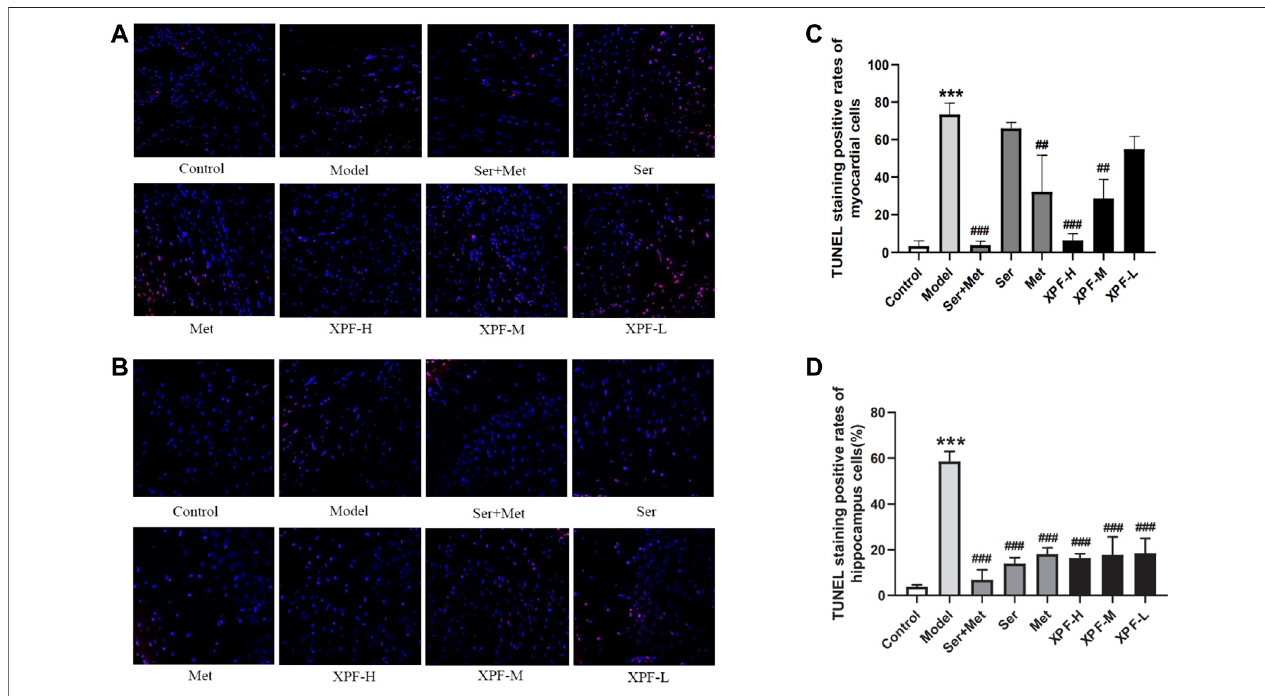
FIGURE 5 | Anti-apoptosis effect of XPF on CUMS and ISO-induced rats ( × 400). (A) Representative images of myocardial apoptosis stained by TUNEL. (B) RepresentativeimagesofhippocampalapoptosisstainedbyTUNEL. (C) Rateofmyocardialapoptosisineachgroup. (D) Rateofhippocampalapoptosisineachgroup. Data wer presented as means ± SD ( n (cid:2) 3). *** p < 0.05 compared with the control group, ## p < 0.01, ## p < 0.005 compared with the model group.